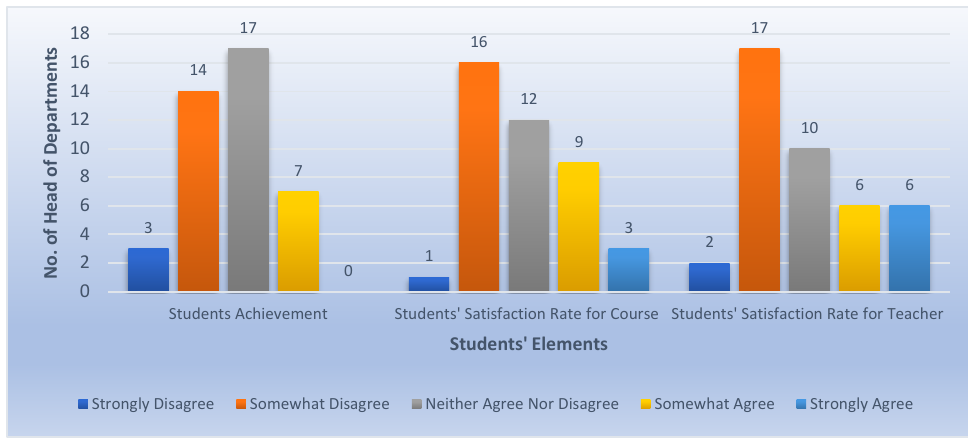
Figure 11. Comparing students ’ feedback elements.